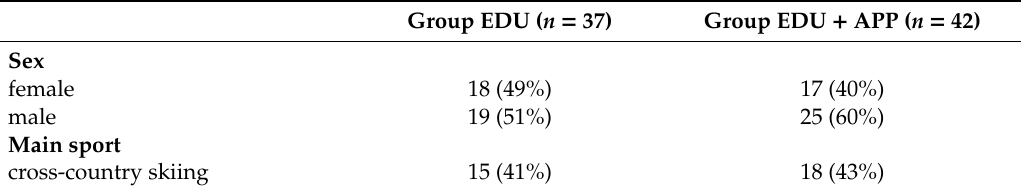
Table 1. Background information on athletes presented as numbers and percentages of participants in